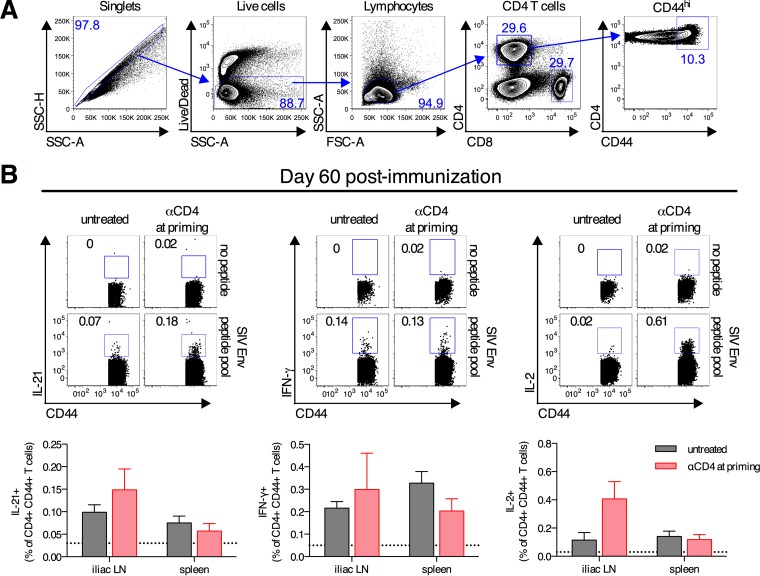
Development of antigen-specific CD4+ T cell responses after transient depletion of CD4+ T cells. (A) Gating scheme for characterization of antigen-specific CD4+ T cells by intracellular cytokine staining. SSC, side scatter; FSC, forward scatter. (B) C57BL/6 mice were depleted of CD4+ T cells at immunization or left untreated and immunized intramuscularly with 1010 vp of Ad26-SIV Env. Spleens and iliac (draining) LNs were collected on day 60 postimmunization, and intracellular cytokine staining was performed to detect the production of IL-21, IFN-γ, and IL-2 by CD44+ CD4+ T cells following stimulation with an overlapping SIV Env peptide pool. Means ± standard errors of the means are shown. The horizontal dotted line denotes the limit of detection for the assay (n = 10/group pooled from two experiments).